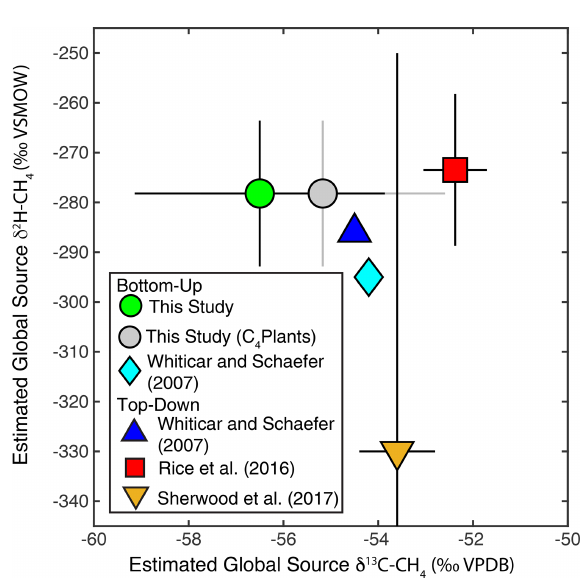
Figure 10. Comparison of estimates of dual-isotope global source δ 2 H–CH 4 and δ 13 C-CH 4 from this and previous studies. Error bars from this study indicate the 2 σ standard deviation from Monte Carlo analysis. Grey dot and error bars indicate an estimate cor- rected for the lack of data from wetlands and biomass burning in C 4 plant environments, as described in Sect. 2.4. Error bars for Rice et al. (2016) indicate the range of values estimated in that study between 1977–2005. Error bars for Sherwood et al. (2017) reflect the combined measurement uncertainty and uncertainty in sink frac- tionations reported in that study. Whiticar and Schaefer (2007) did not provide uncertainties for their